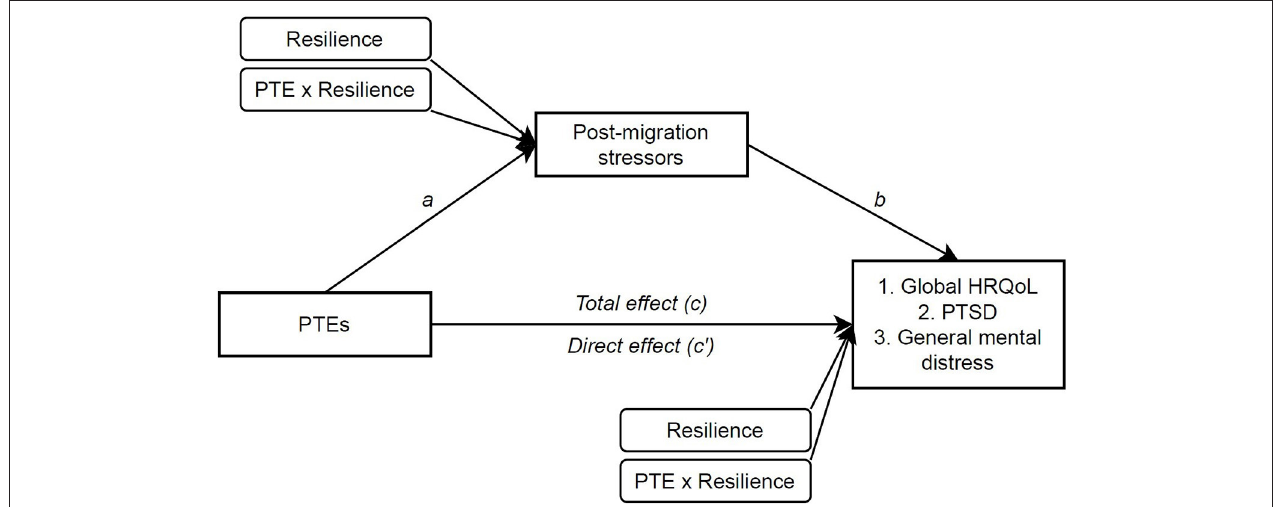
FIGURE 1 | Conceptual model of moderated mediation analyses, SPSS PROCESS model 8. Paths a represent the relationship between the predictor and the mediator, and path b between mediator and outcome whilst the predictor value is controlled. The c ′ path is the direct effect between the predictor and the outcome excluding the mediator variables. The indirect effect is indicated by a statistically significant difference between c and c ′ . The indirect effect would be significant if CIs do not include zero. “Resilience” indicates the direct main effect (promotive resilience), and “PTE × Resilience” indicates the interaction term (protective